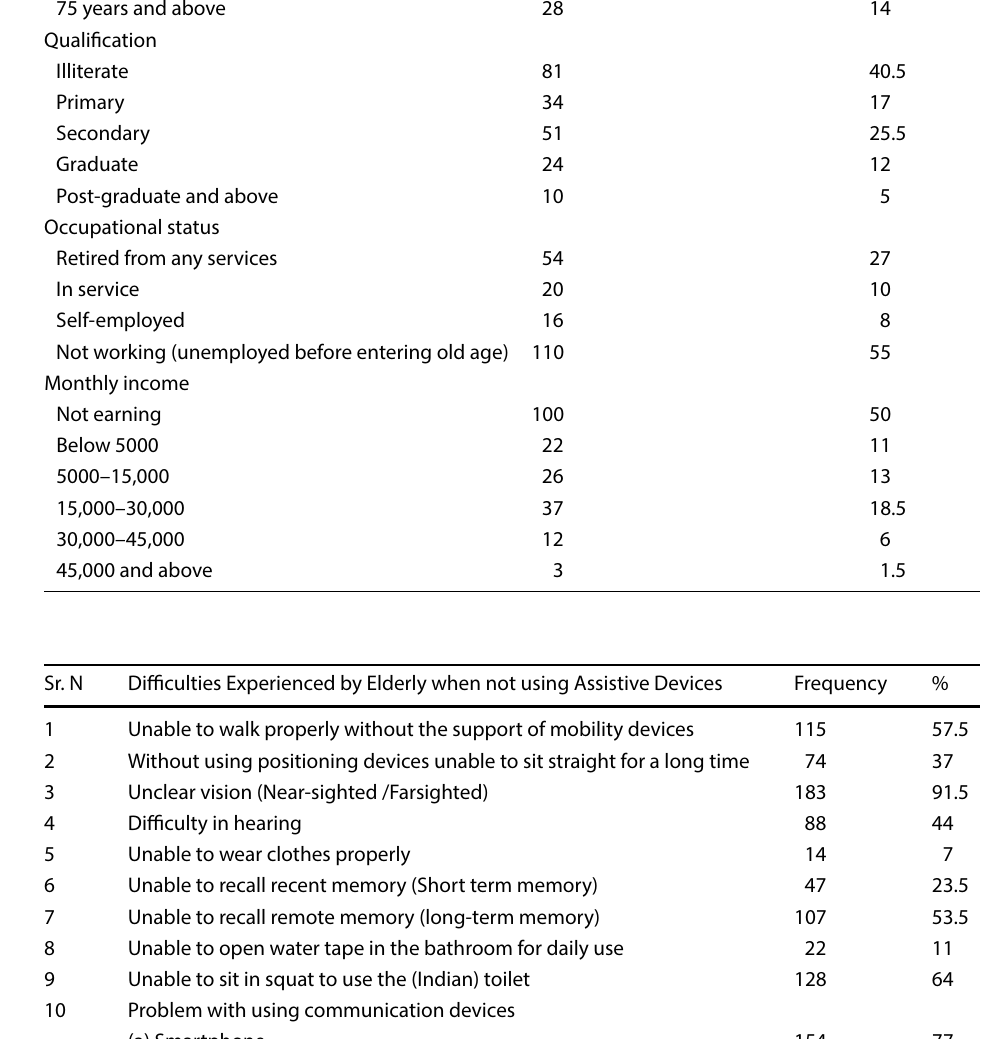
Table 1 Distribution of respondents as per socio- demographic profile